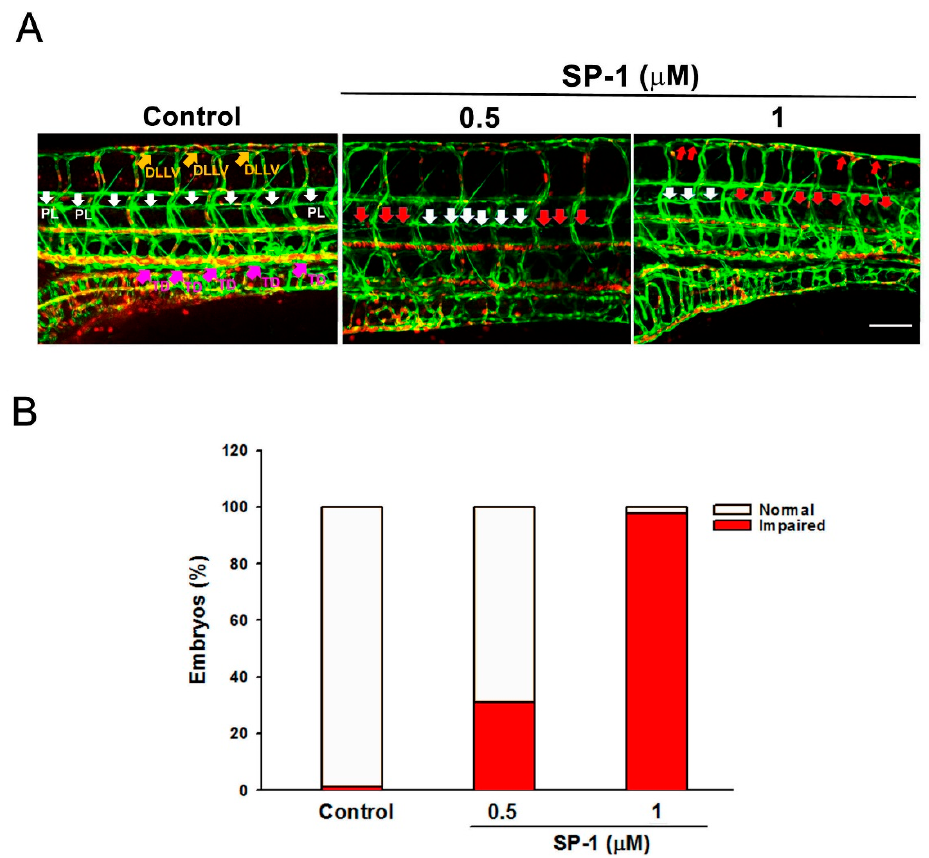
Figure 2. Heteronemin blocks thoracic duct development in zebrafish model. Transgenic (fli1:EGFP;gata1:DsRed) zebrafish embryos were treated with the indicated concentrations of heteronemin (represented as SP-1), and then thoracic duct length was analyzed via fluorescence microscopy. DLLV indicated as dorsal longitudinal lymphatic vessel (orange arrows); PL, parachordal LEC (white arrows) and TD, thoracic duct (pink arrows). ( A ) Representative pictures of thoracic duct of zebrafish treated with indicated concentration of SP-1 (bar = 100 µ m). ( B ) Quantification of the defective formation of thoracic duct at 5 dpf determined by the percentages of embryos. A total of 50 embryos were analyzed in each experimental condition.